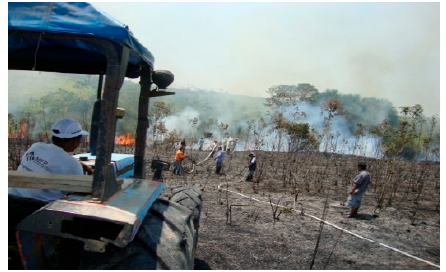
Figure 15. Organization for fire control. Forests 2018 , 8 , x FOR PEER REVIEW